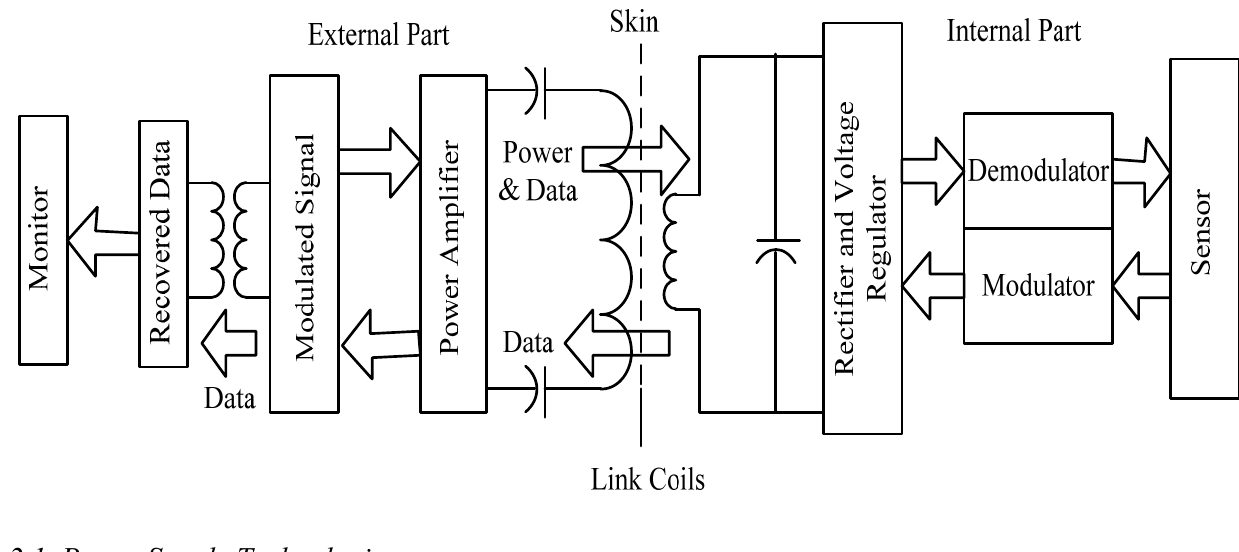
Figure 1. Architecture for data and power transmission